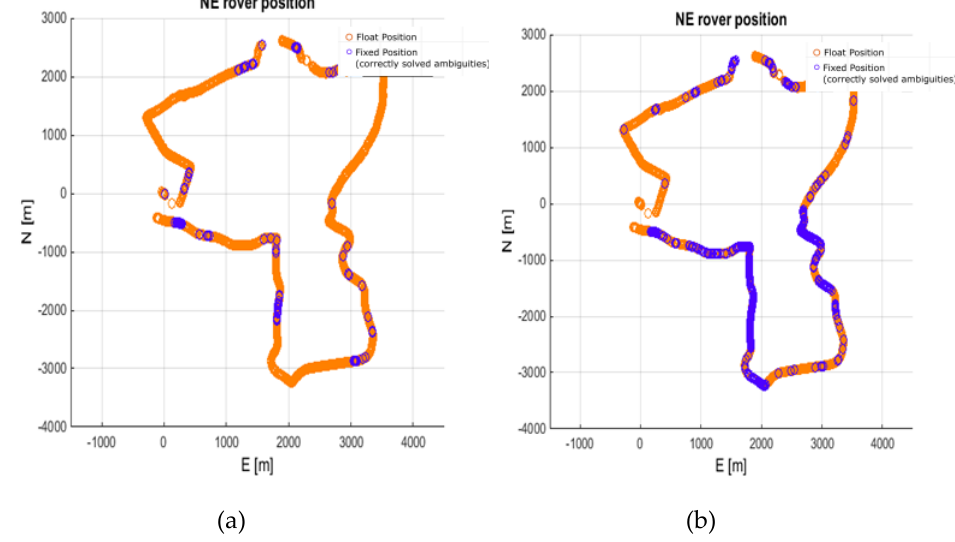
Figure 11. Rover trajectory from processing 82 km baseline (BROD). ( a ) No ionospheric corrections; ( b ) With ionospheric corrections.